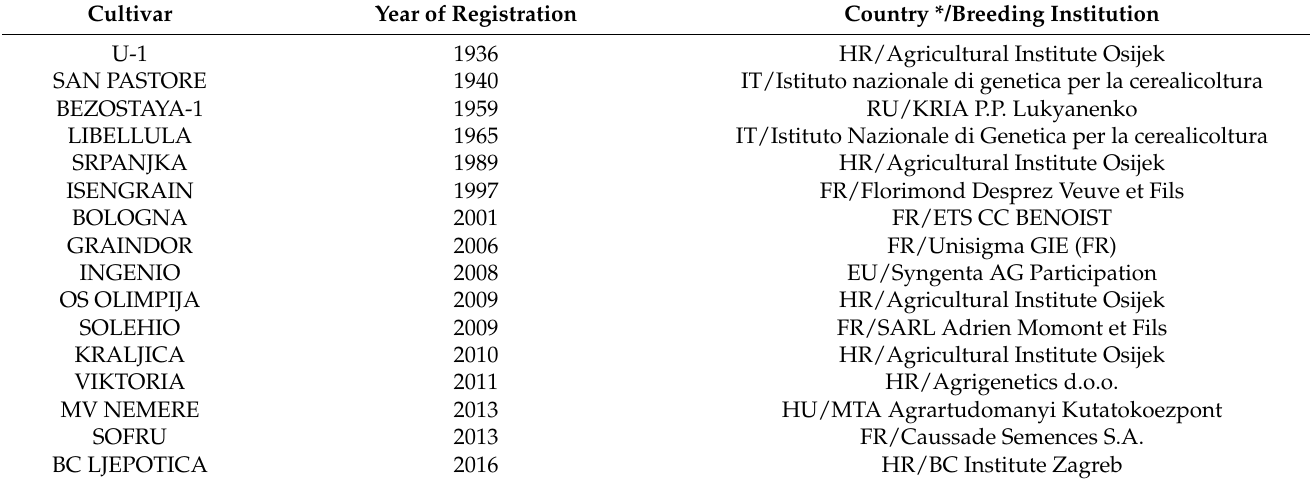
Table 1. List of wheat cultivars, year of registration, country of origin and breeding institution.